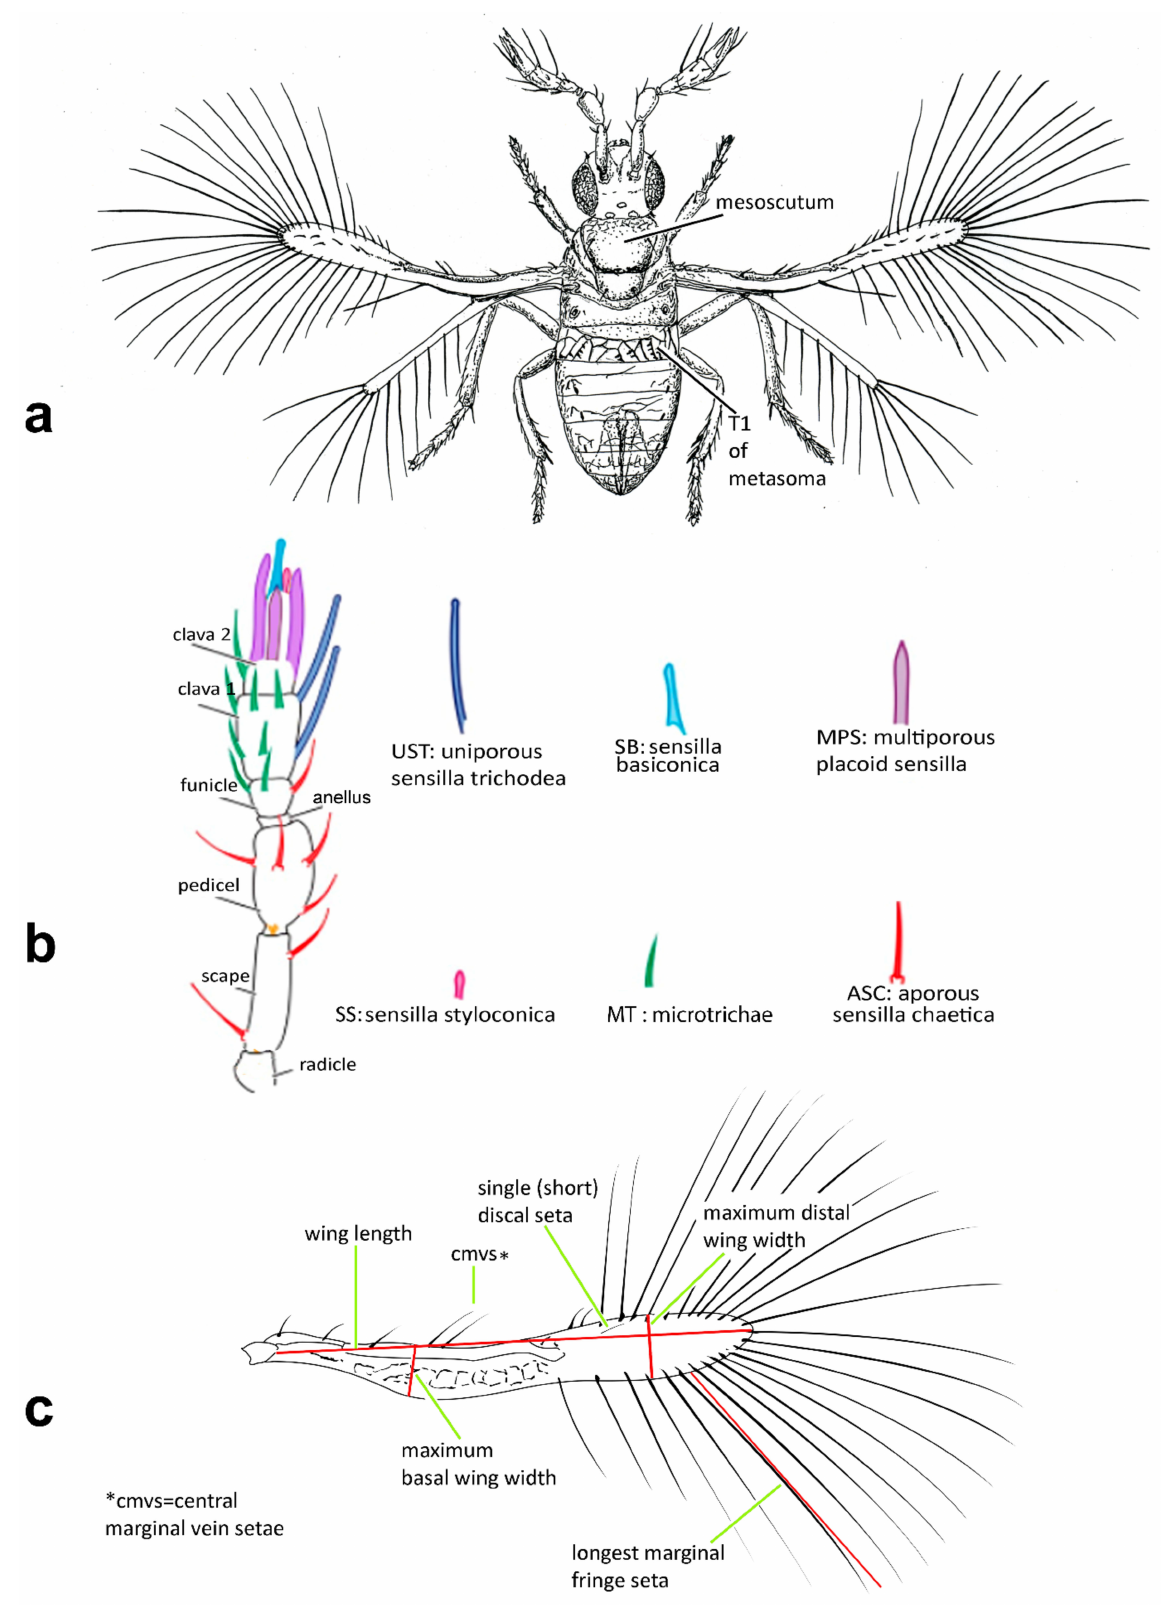
Figure 1. Line drawings of Megaphragma species: ( a ) M. mymaripenne , female habitus; ( b ) Megaphragma sp., stylized antenna; ( c ) Megaphragma sp. ghesquierei -group, fore